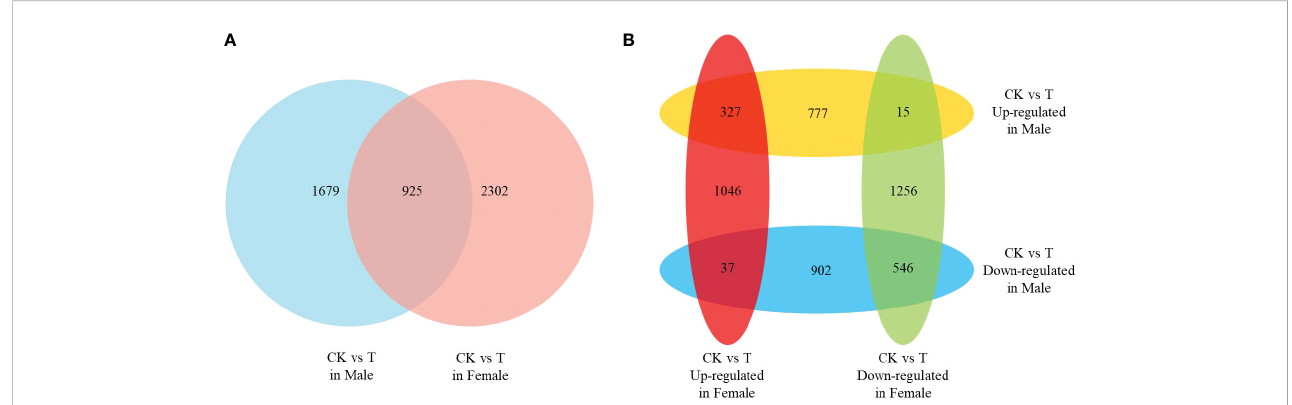
FIGURE 2 The differentially expressed genes (DEGs) of females and males response to salinity stress. (A) Venn analysis of the DEGs in females and males. (B) Venn analysis of the up- and down-regulated DEGs in females and